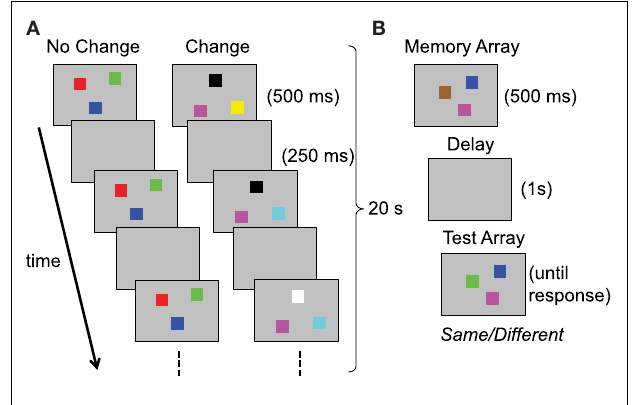
FIGURE 1 | Schematic illustrations of tasks used to assess visual working memory in (A) infants versus (B) children and adults; both present examples of set size